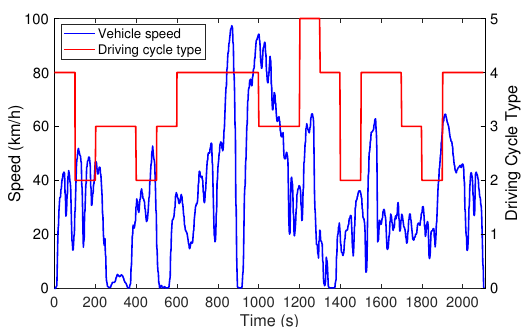
Figure 18. The result of driving cycle recognition by ELM.